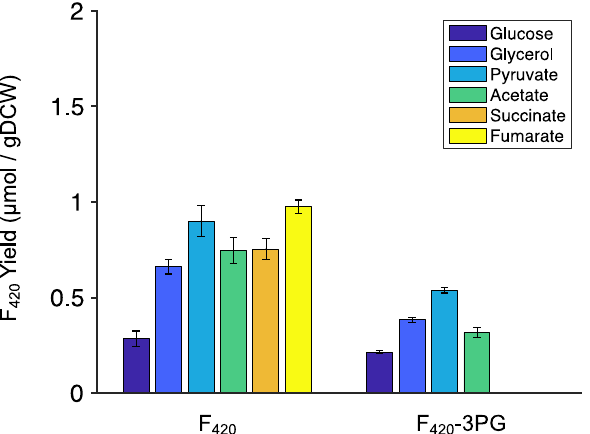
Figure 5. F 420 yield (in µmol per grams of dry cell weight) at the end of exponential phase of E. coli growth with different carbon sources. 3PG-F 420 and F 420 refer to the biosynthesis of the cofactor F 420 derived from 3-phospho glycerate and PEP, respectively, as the substrates of FbiD. Error bars show standard errors of the mean of at least two